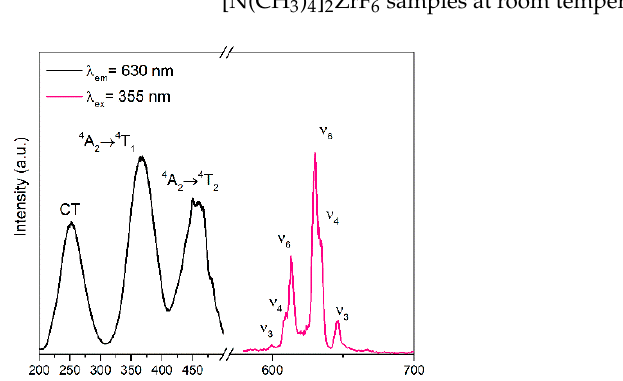
Figure 4. ( a ) Diffuse reflectance spectrum and ( b ) energy band gap of pure and Mn 4+ doped [N(CH 3 ) 4 ] 2 ZrF 6 samples at room temperature.